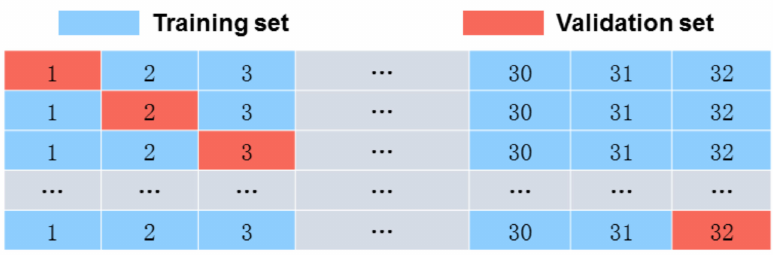
Figure 4. Configuration of leave-one-out cross-validation.